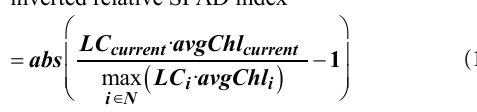
( Figure 3A ; Supplementary Figure 6 ; Supplementary Table 5